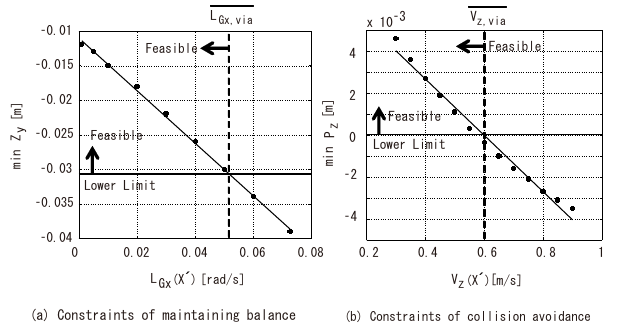
Figure 6. Limitations of velocity at the via-point and bound values of nonlinear constraints. (a) relation between the upper limit of centrical angular momentum at the via-point in x axis and the lower bound of planned ZMP trajectory in y axis. (b) relation between the upper limit of swing foot’svelocityatthevia-pointin z axisandthelowerboundofplanned swing foot’s position trajectory in z axis.